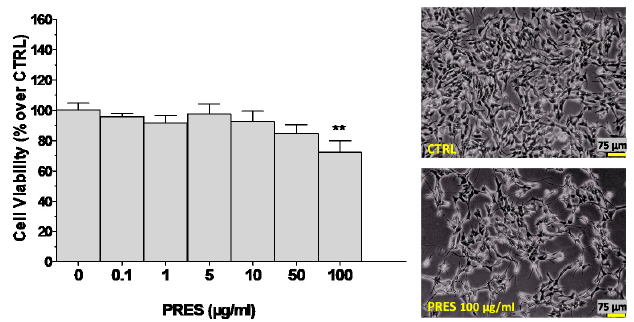
Figure 1. Effects of Pres phytum (PRES) on SH-SY5Y cell viability. The cells were incubated with increasing concentrations of PRES (0–100 µg/mL, 24 h) and an MTT test was performed. Data are reported as mean ± SEMs. ** p < 0.01 vs. untreated cells (one-way ANOVA and Bonferroni post-test). Upper panels: Morphological analysis at contrast phase microscopy between untreated (CTRL) and PRES-treated (100 µg/mL for 24 h) SH-SY5Y cells (scale bar 75 µm) was performed according to USP 28 (United States Pharmacopeia edition 2005) grade scale for assessment of the cytotoxic potential of tested materials. Each photograph was representative of 3 independent observations.